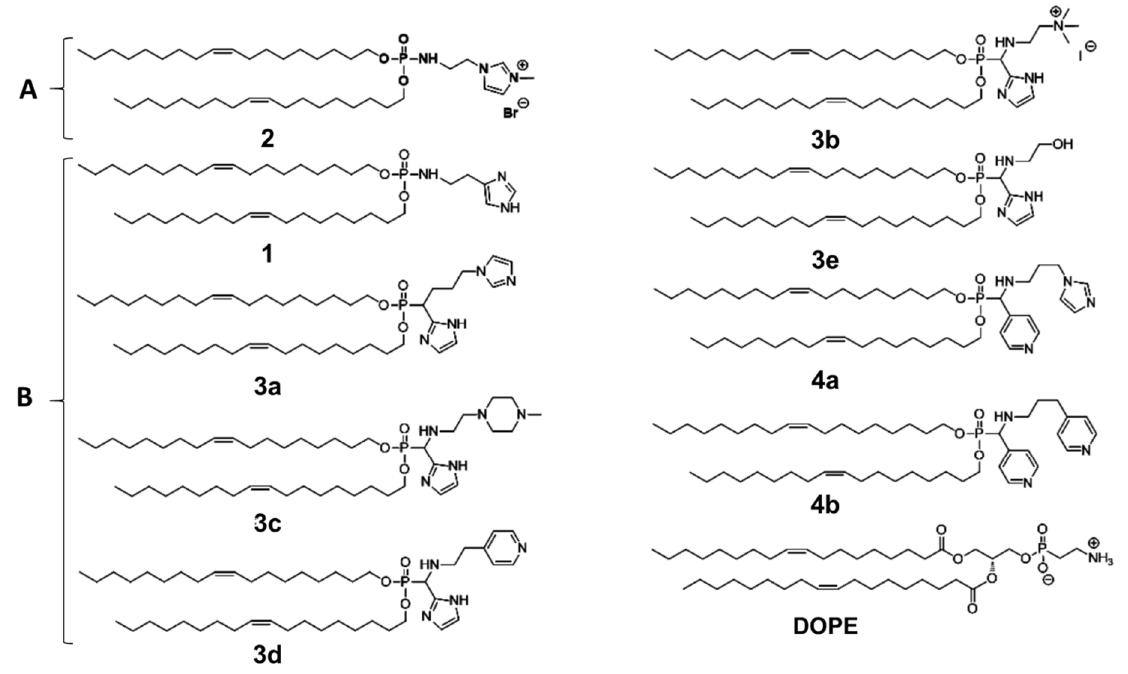
Figure 1. Molecular structure of lipids used in this work ( A ) cationic lipids and ( B ) co-lipids.